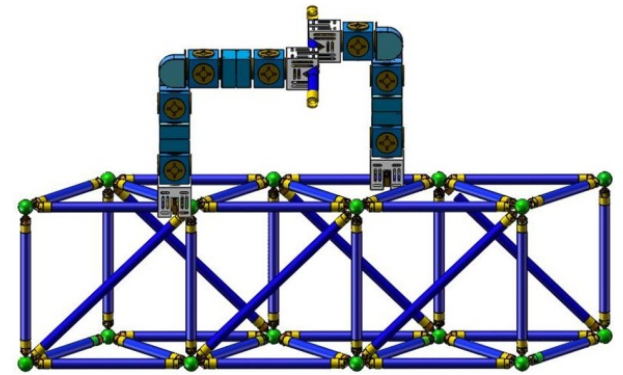
Figure 16. Solid model of robot truss assembly.